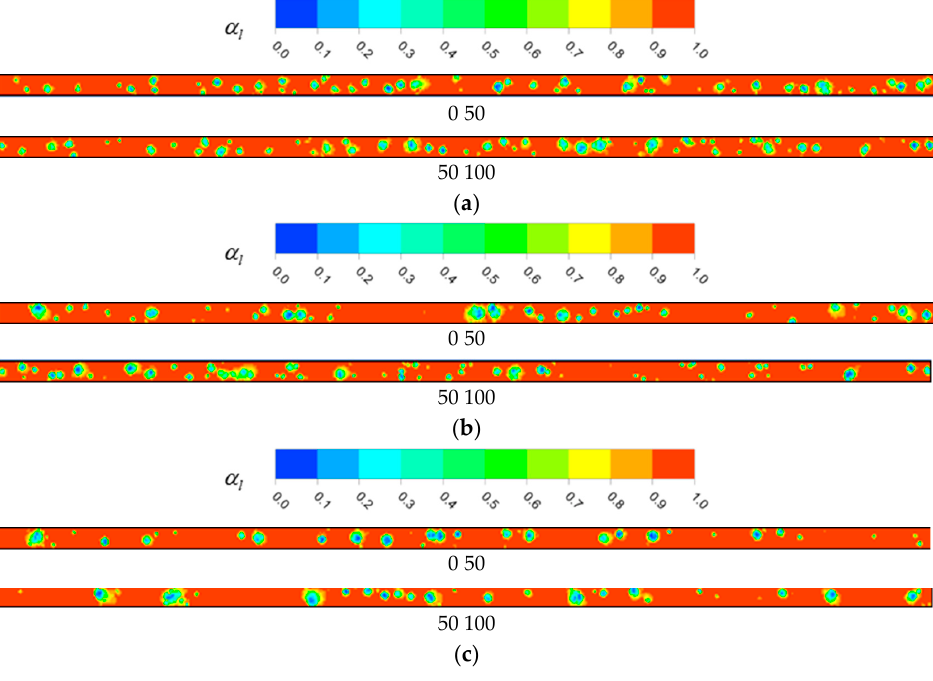
Figure 9. Volume fraction distribution of az-refrigerant liquid phase at different T sat values: ( a ) T sat = 253 K, G = 50 kg/m 2 s, q = 10 kW, X = 0.26; ( b ) T sat = 263 K, G = 50 kg/m 2 s, q = 10 kW, X = 0.29; ( c ) T sat = 273 K, G = 50 kg/m 2 s, q = 10 kW, X = 0.32.